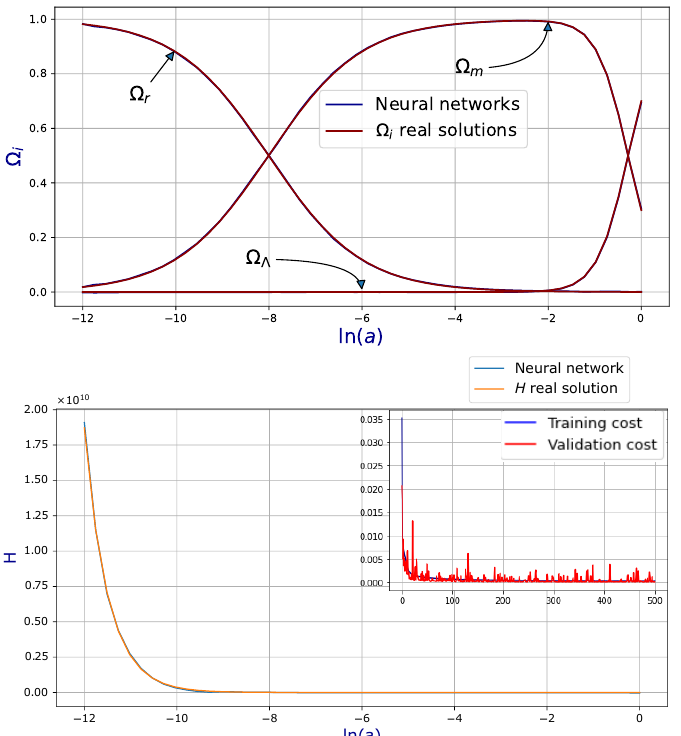
Figure 6. Comparison between the trained model and the real solutions, evaluated over the whole domain ln ( a ) ∈ [− 12,0 ] , with Ω m ,0 = 0.3, H 0 = 70, for the density parameters ( top ) and the Hubble parameter ( bottom ). In the upper right corner we can see the evolution of the error during the training process.